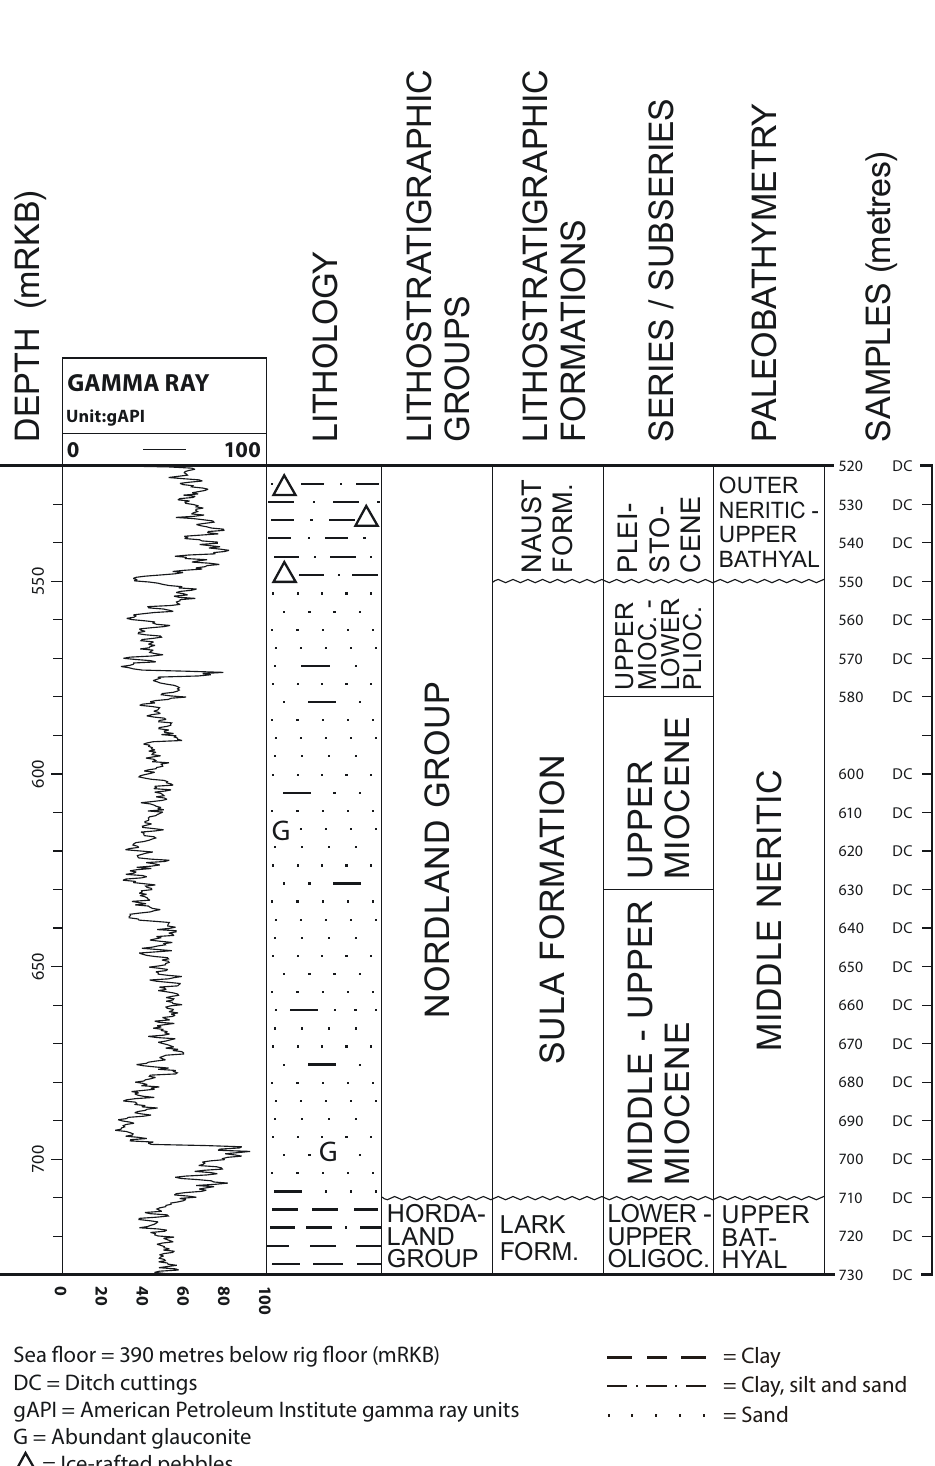
= Clay = Clay, silt and sand = Sand